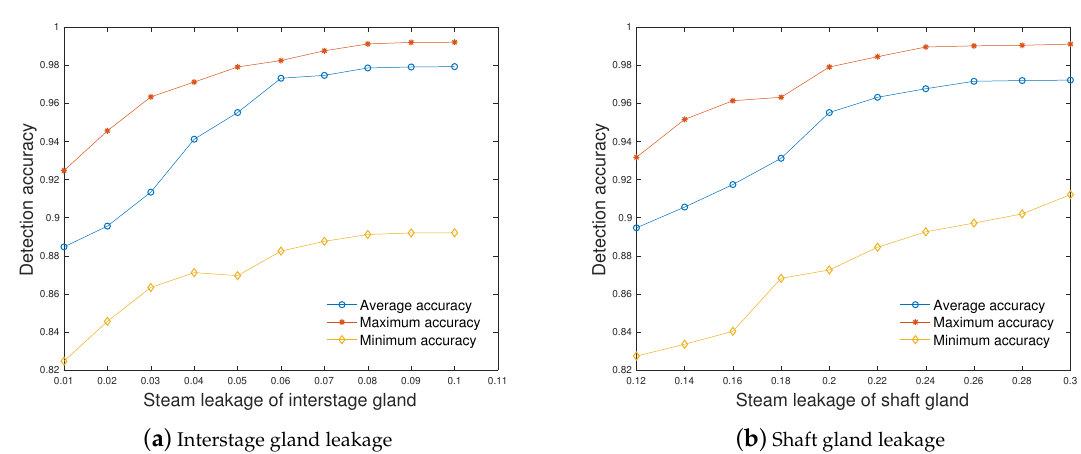
Figure 6. Fault propagation accuracy under different steam leakage.